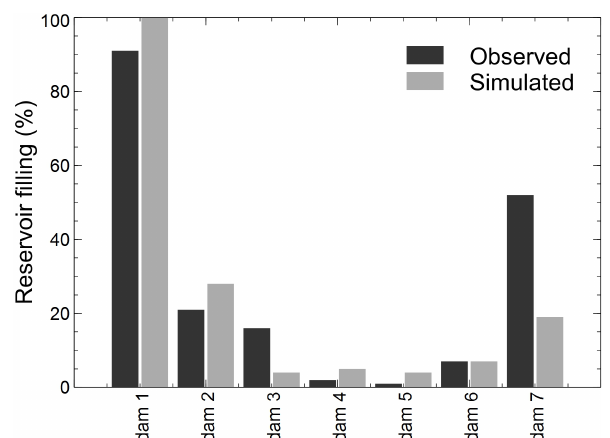
Fig. 13. Sediment sub-model spatial validation at seven check dams (“secondary check dams”), comparing the observed and simulated degree of reservoir